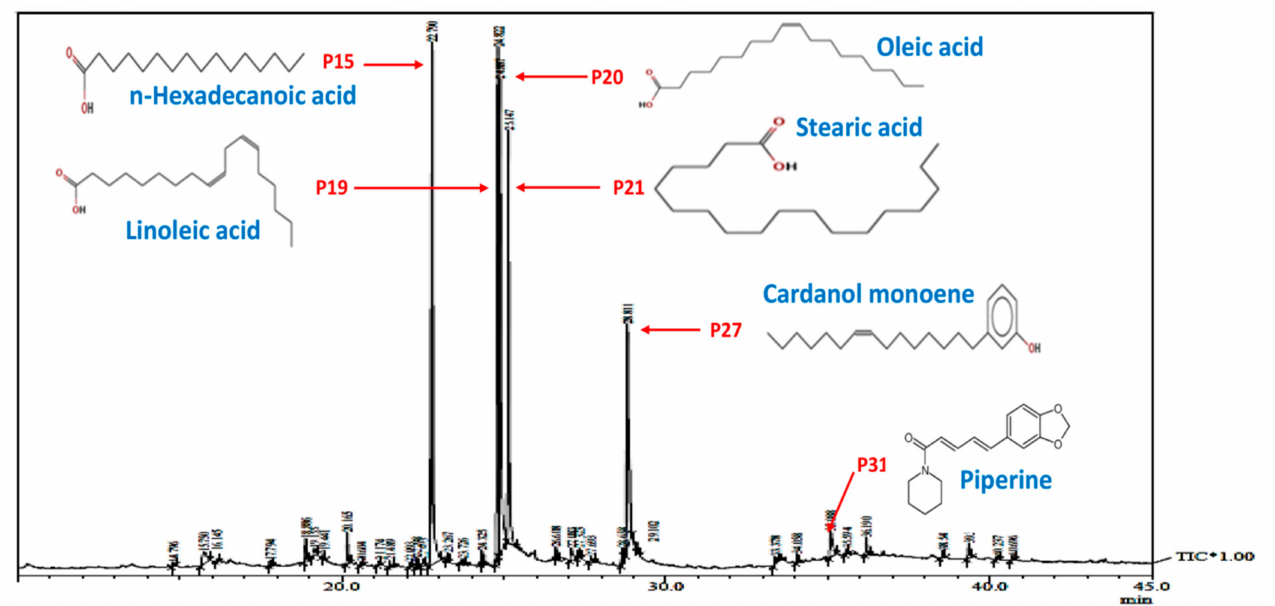
Figure 3. Gas chromatography mass-spectroscopic analysis. Typical GC–MS chromatogram of PLE showing a total 37 peaks (P) for different bio-actives compounds including six major compounds as n-hexadecanoic acid (P15—21.95%), linoleic acid (P19—20.45%), oleic acid (P20—18.01%), stearic acid (P21—13.99%), cardanol monoene (P27—11.92%) and piperine (P31—1.83%).